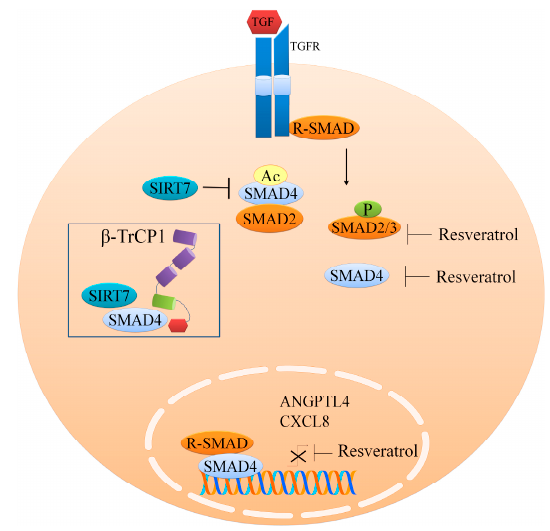
Figure 1. TGF/TGFR signaling axis. SMAD proteins play a central role in transducing the signals intracellularly. SIRT7 modulates SMAD4 degradation via β -transducin repeat-containing protein ( β -TrCP1). SMAD4, β -TrCP1, and SIRT7 complex formation results in shutdown of the TGF pathway. SMAD: Sma Mothers Against Decapentaplegic; β -TrCP: β -transducin repeat-containing protein; CXCL8: chemokine CXC motif, ligand 8; TGF: transforming growth factor; ANGPTL4: angiopoietin-like